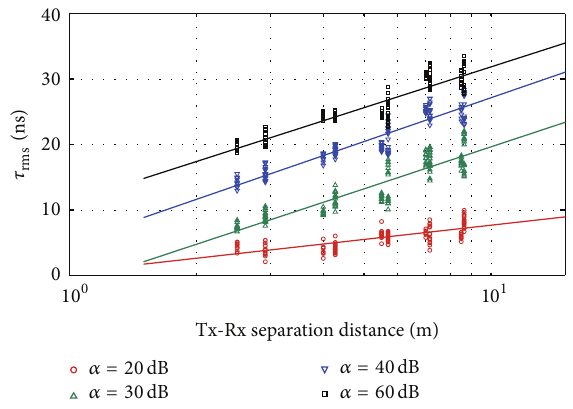
Figure 6: Scatter plot of rms delay spread versus Tx-Rx separation distance. The solid line corresponds to the linear fit.